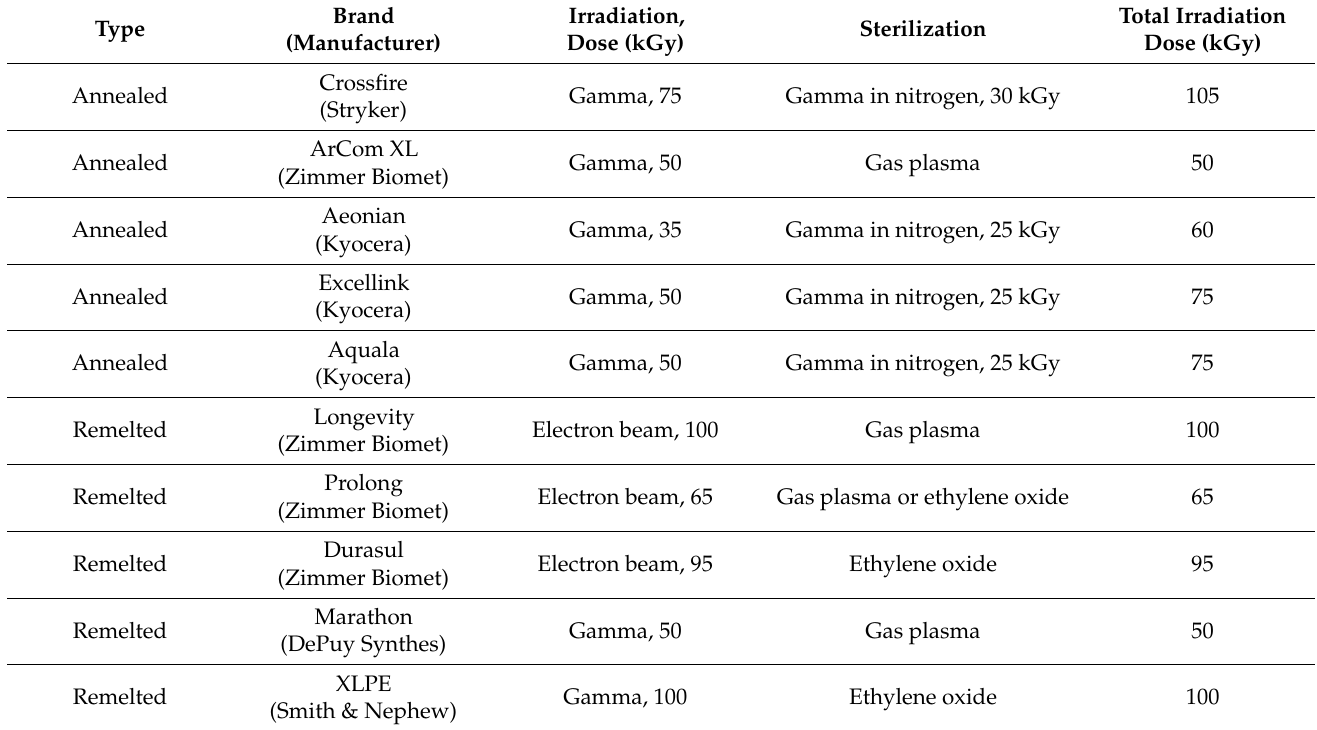
Table 1. First-generation highly crosslinked